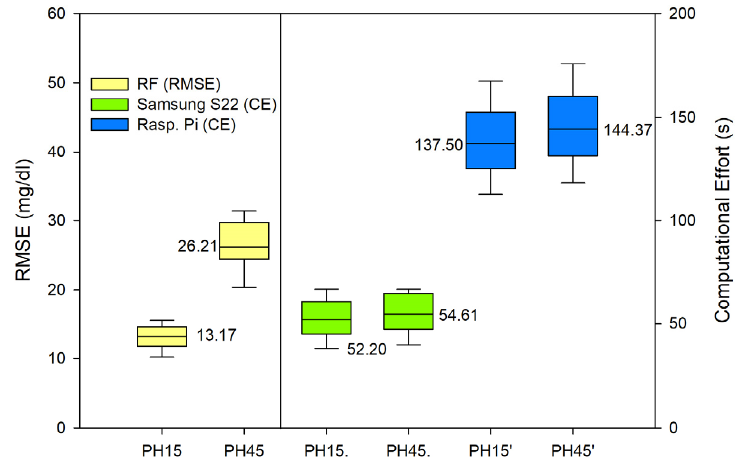
Figure 3. RMSE for RF predictions. PH 15 min and 45 min. CE of both PH executed in smartphone and Raspberry Pi.